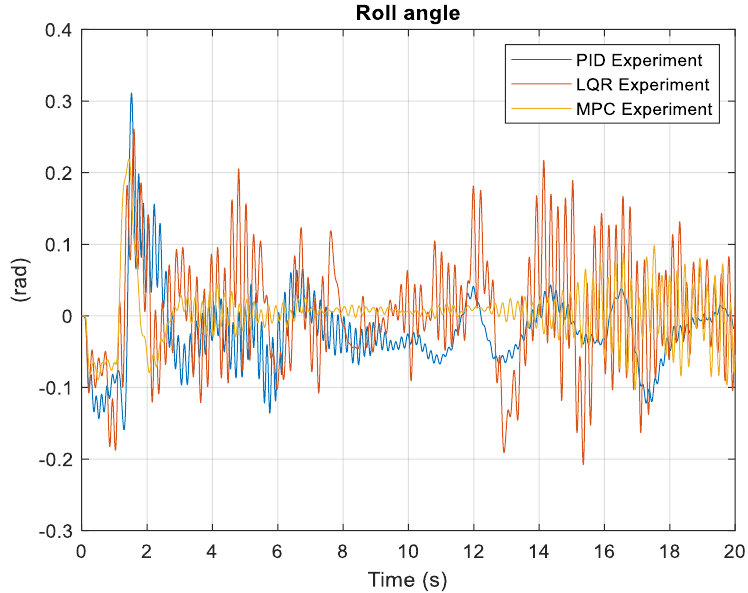
Figure 12. Performance of the controllers for roll angle in real-time.